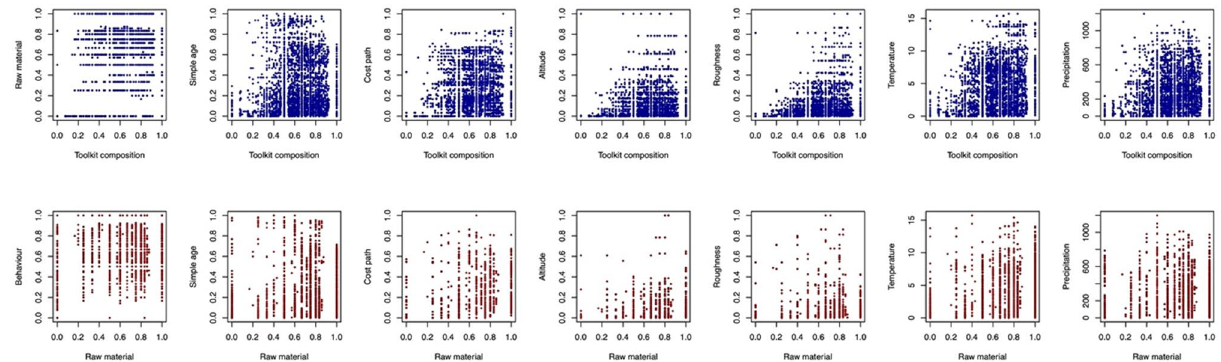
Figures 6. Scatterplots of the Mantel test results (Table 1, Supplementary Table S4–S5) between the pairwise distance matrix of toolkit composition (top) and raw material use (bottom) and the other distances matrices excluding the two binary variables, site type and method.